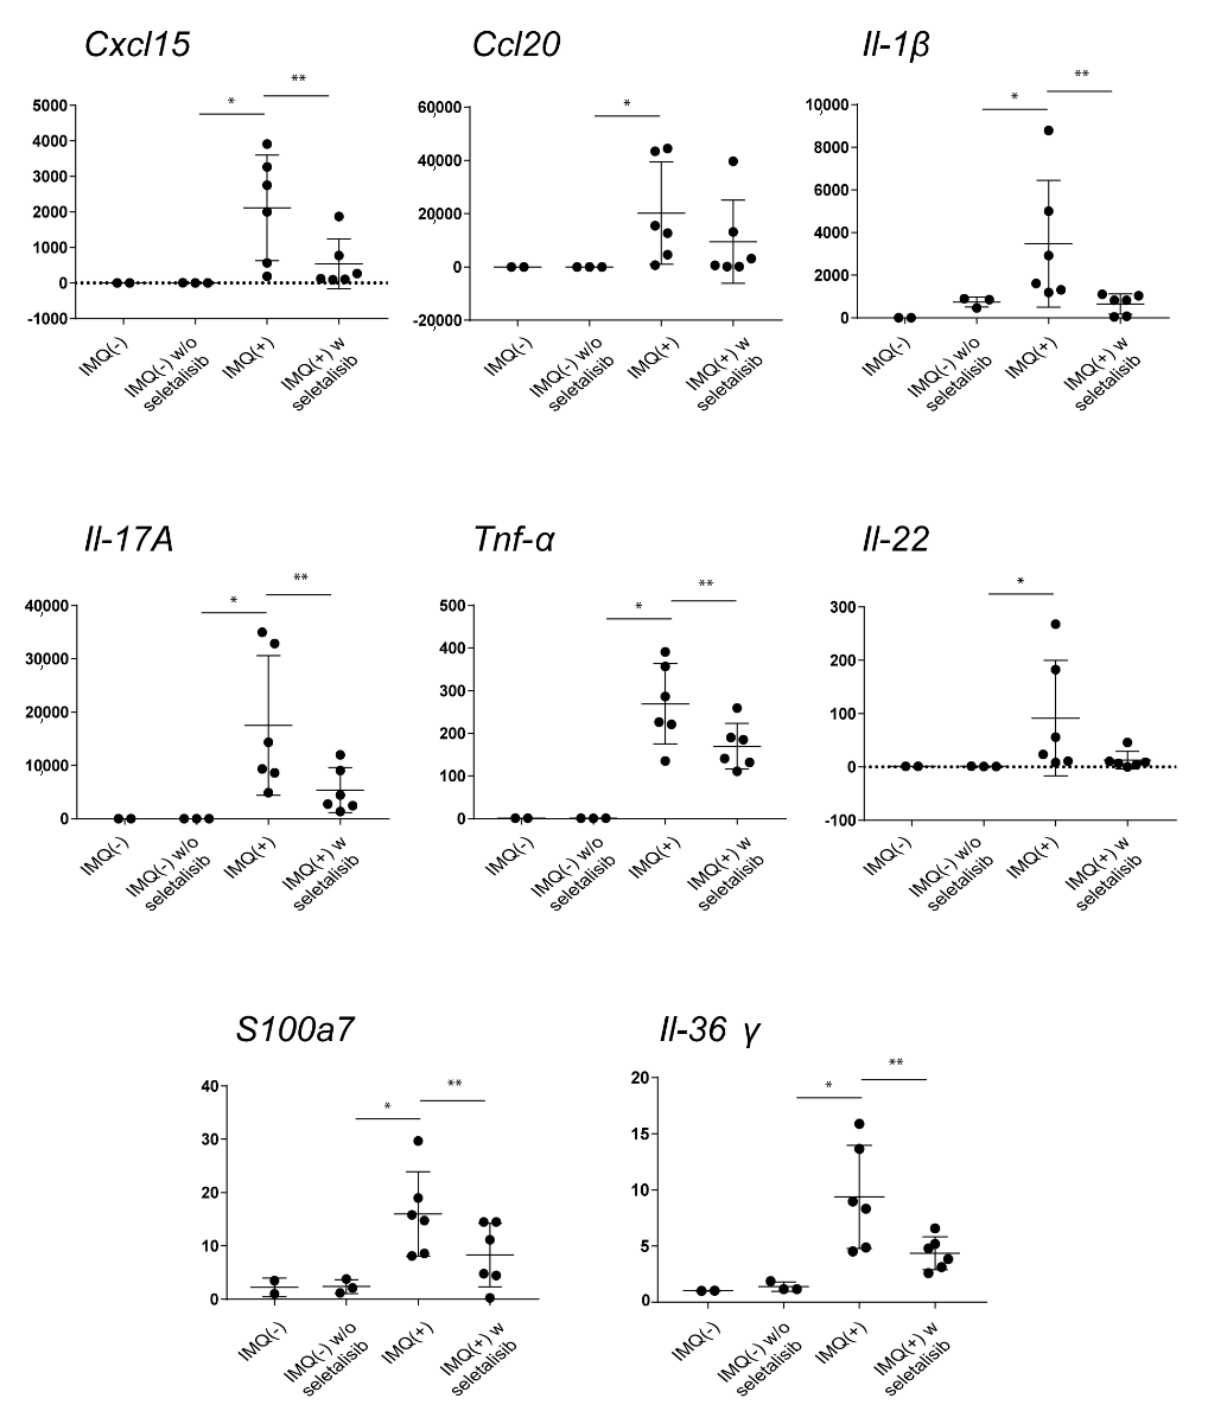
Figure 7. PI3K δ inhibition by seletalisib counteracts the expression of pro-inflammatory molecules in IMQ-psoriasis-like mouse model. Cxcl15 , Ccl20 , IL-1 β , Il-17a , Tnf- α , Il-22, S100a7 , and Il-36 γ mRNA expression was detected by